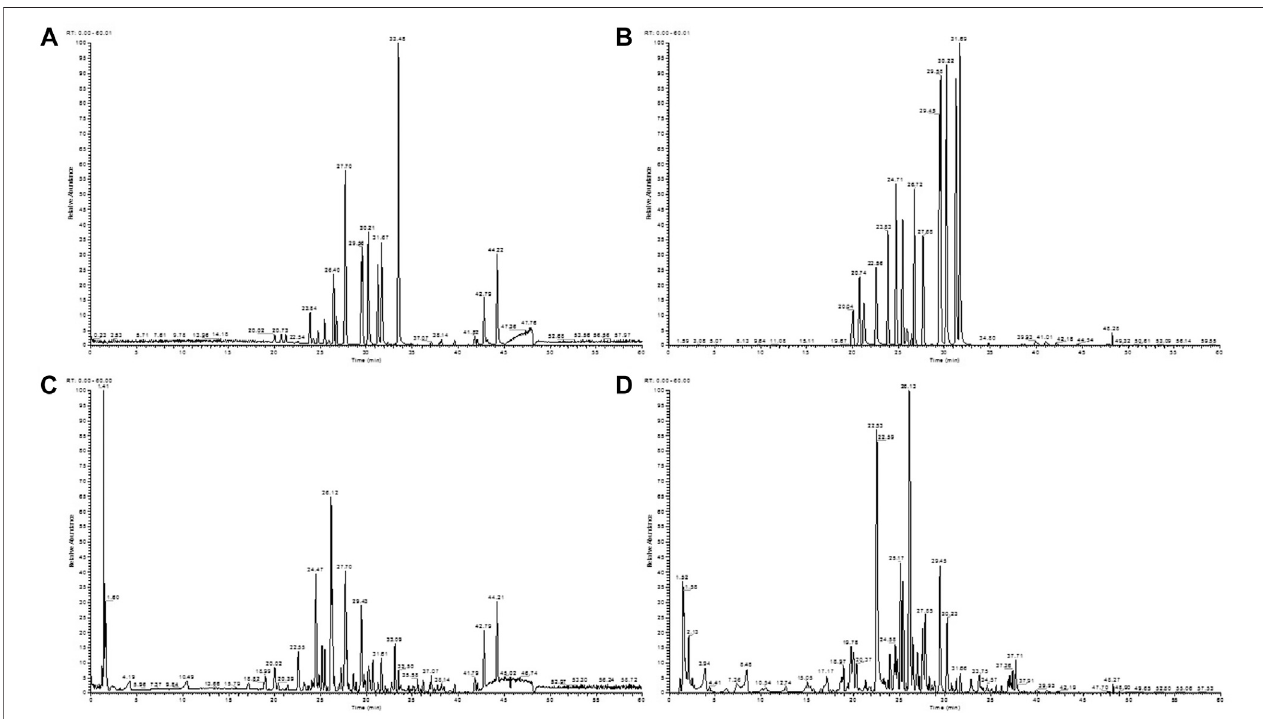
FIGURE 3 | Total ion chromatograms of a mixture of 14 standards obtained from the negative (A) and positive (B) ion scan modes. LXJD formula extract obtained from the negative (C) and positive (D) ion scan modes.